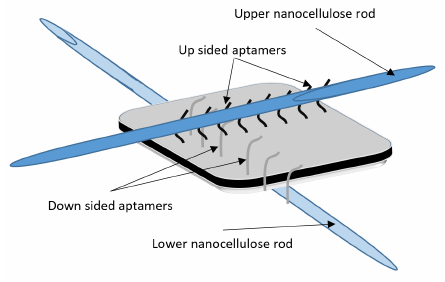
Figure 1. DNA origami functionalized by orthogonally aligned specific aptamers, placed on opposite sides, and connected to rod-like